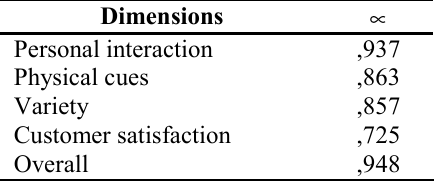
Table 2: Reliability analysis results